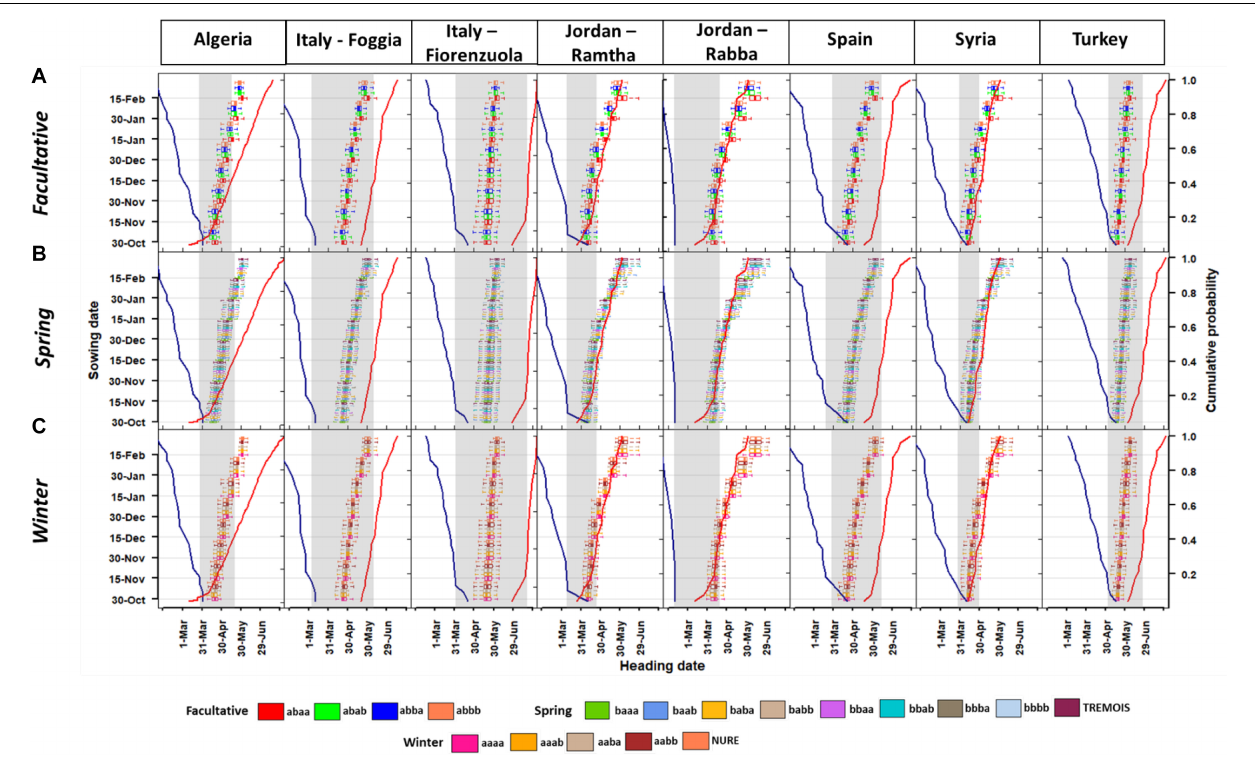
FIGURE 2 | Boxplots of the heading date at different sowing times for the (A) facultative, (B) spring, and (C) winter barley types. The secondary axis shows the probability for the last frost days (blue line on the left) and first heat days (red solid line on the right), these are calculated as the percentile of last frost days ( < 0 ◦ C) and first heat days ( > 35 ◦ C) from 1980 to 2010 and defined as 10% of risk for the last day of frost and 40% for first day of heat as defined in previous work (Zheng et al., 2013). For each boxplot, the end of the horizontal line represents, from the left to the right, the 10th percentile and the 90th percentile. The vertical line of the box, from the left to the right represents the 25th and 75th percentile,